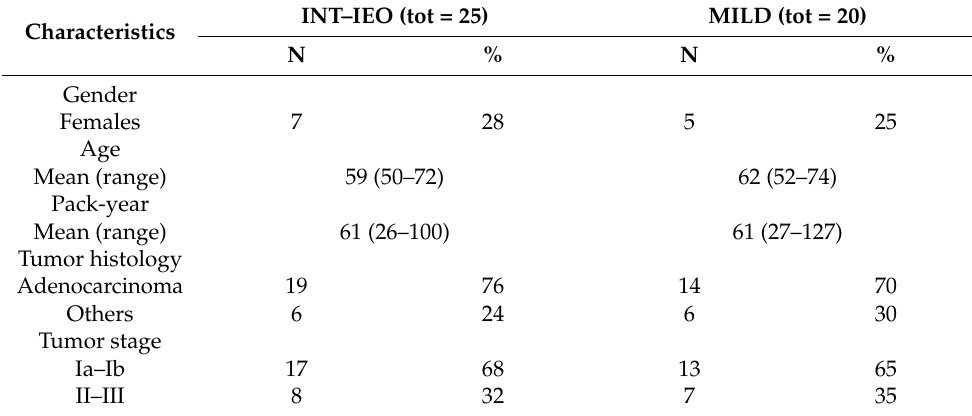
Table 1. Clinico-pathological characteristics of lung cancer screening patients.